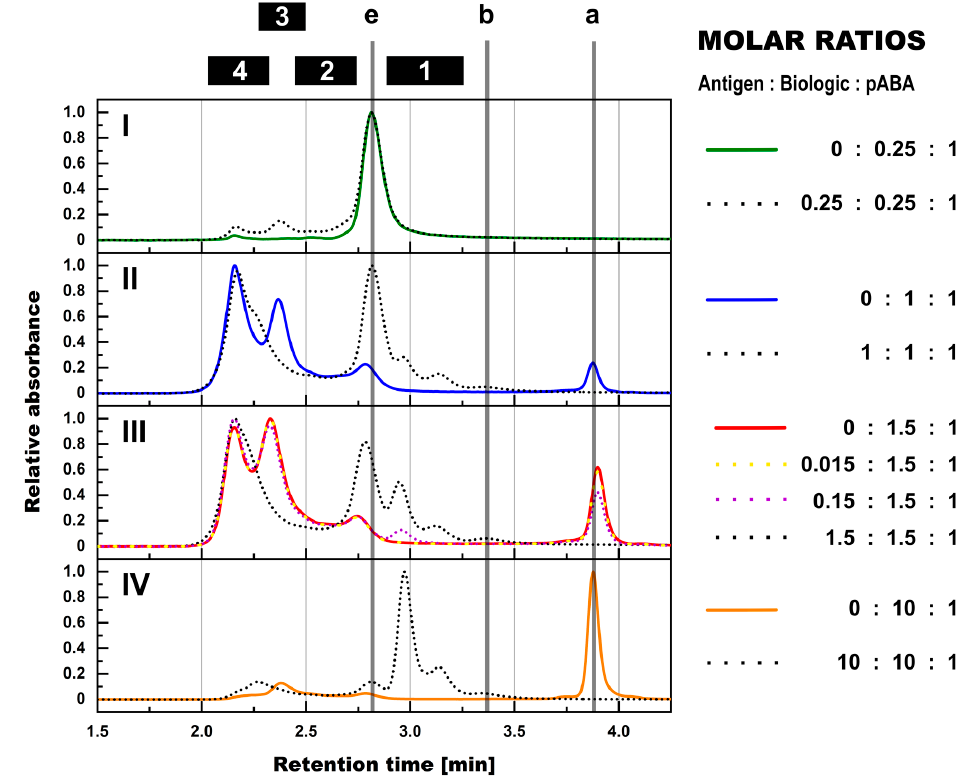
Figure 3. SEC assessment of formed immune complexes in PBS in presence and absence of antigen and the impact of molar ratios between biologic and pABA. Normalized SEC-UV profiles are shown for biologic:pABA compositions of the following molar ratios in absence (full line) and in presence of antigen (dotted lines)—0.25:1 on panel ( I ), 1:1 on panel ( II ), 1.5:1 on panel ( III ), and 10:1 on panel ( IV ). Presence of antigen in equimolar ratio to biologic and according to figure legend for the 1.5:1 biologic:pABA ratio. Marker: (a) free biologic, (b) free antigen, (e) free pABA, (1) antigen:biologic complexes, (2) immune complexes with a single ABA incorporated, (3) immune complexes with two incorporated ABAs, (4) immune complexes with more than two incorporated